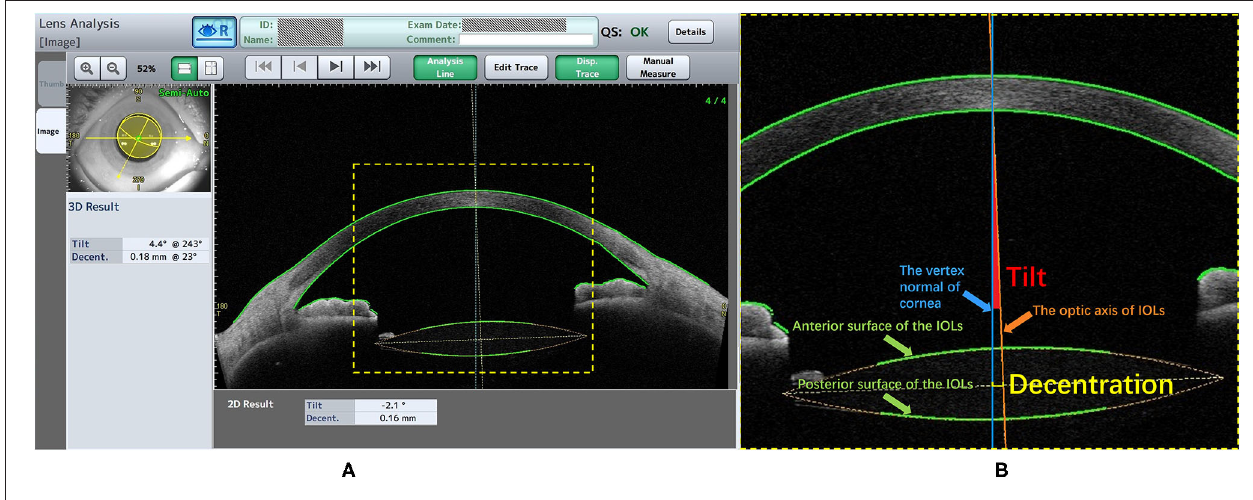
FIGURE 1 | The lens analysis of CASIA2 examination. (A) The information of patient and the Quality Score (QS) were shown above, left window showed the 3D result and right window showed one of eight anterior segment images. The 3D result contained the value and the azimuth of the IOLs tilt and decentration. (B) The Green line (Pointed by the Green arrow): the trace lines on the anterior and posterior surface of the IOLs; The Orange line (Pointed by the Orange arrow): the IOLs optic axis which was defined as a perpendicular line with the center of equator circle of IOLs; The Blue line (Pointed by the Blue arrow): the vertex normal of cornea. The decentration (The short yellow line) was defined as a distance between vertex normal and the center of equator circle of lens. The tilt (The red area) was defined as an angle between vertex normal and optic